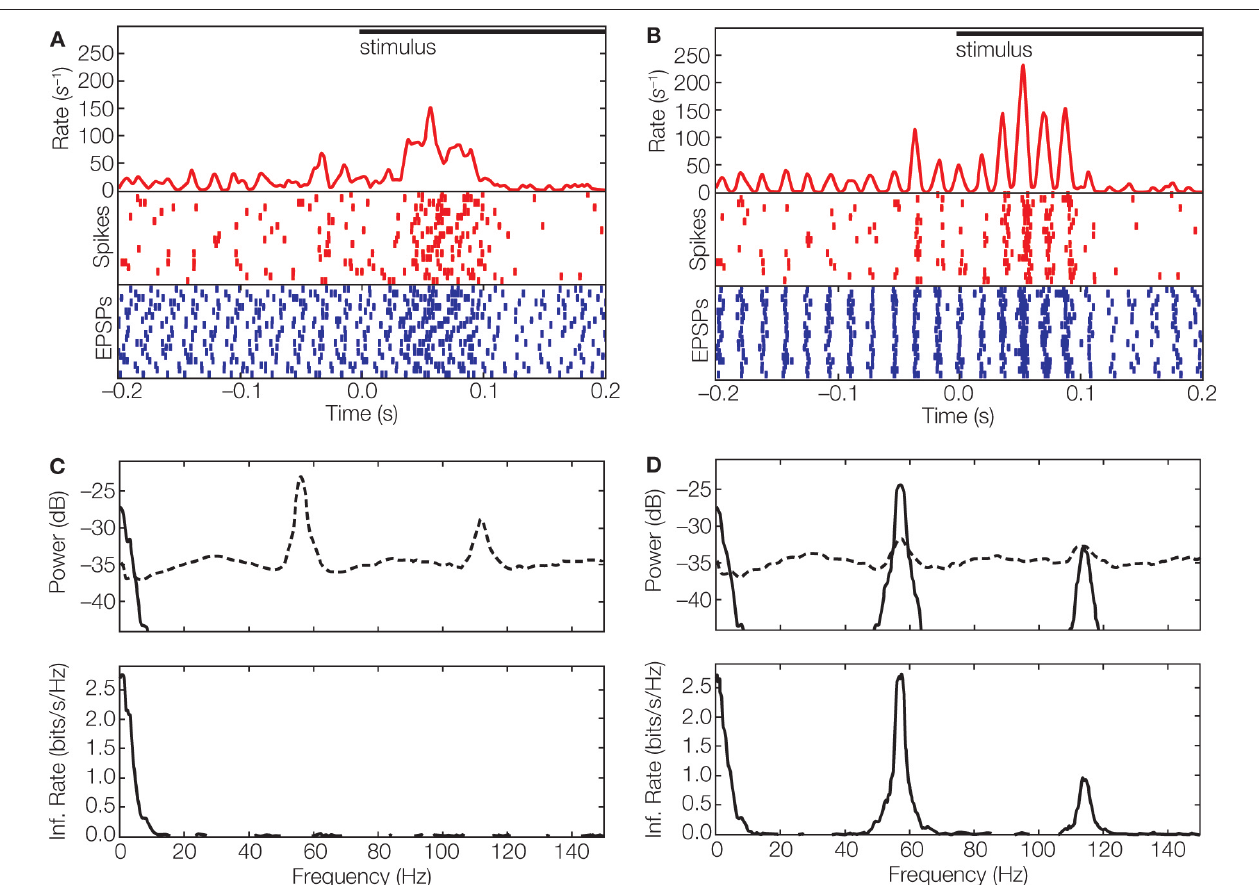
under the curve corresponds to a total information rate of 12.7 bit/s; the mean spike rate 29 spikes/s yields a value of 0.4 bit/spike. (D) Power spectrum (top) of de-jittered spike train decomposed into signal (solid line) and noise (dashed line); spectral information rate (bottom). De-jittering increased the total information from 0.4 bit/spike (C) to 1.2 bit/spike (Koepsell et al., 2009). The movie stimulus was presented with 30 frames/s on a monitor with a high refresh rate (150 Hz). The neural response did not lock to the frame update or monitor